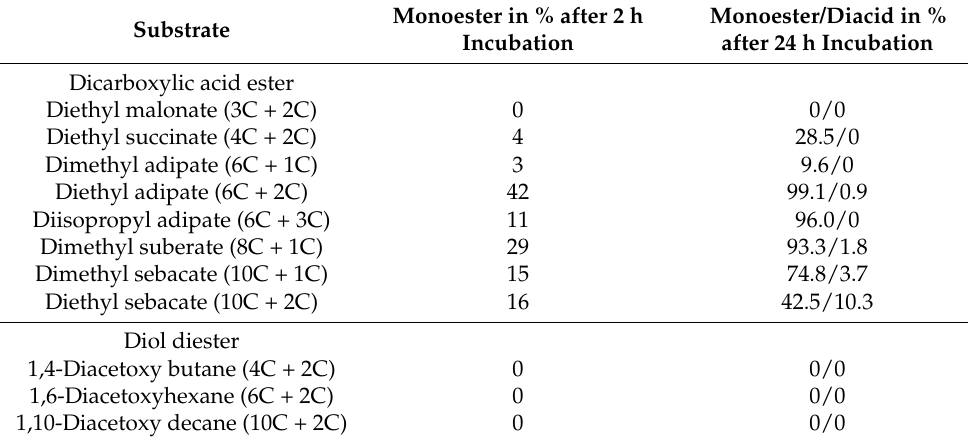
Table 5. Substrate spectrum of purified free